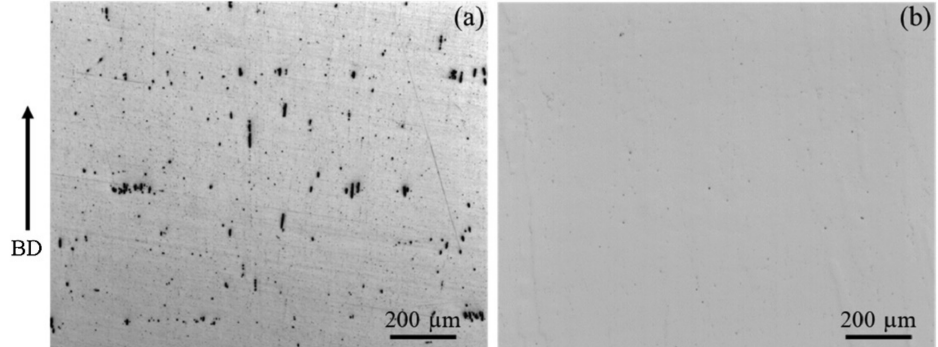
Figure 1. Optical micrographs presenting defects. ( a ) Electron beam melting (EBM) part with obvious defects. ( b ) Optical microstructure after the hot isostatic pressing (HIP) treatment. (Reprinted with permission from ref. [75]. Copyright 2019